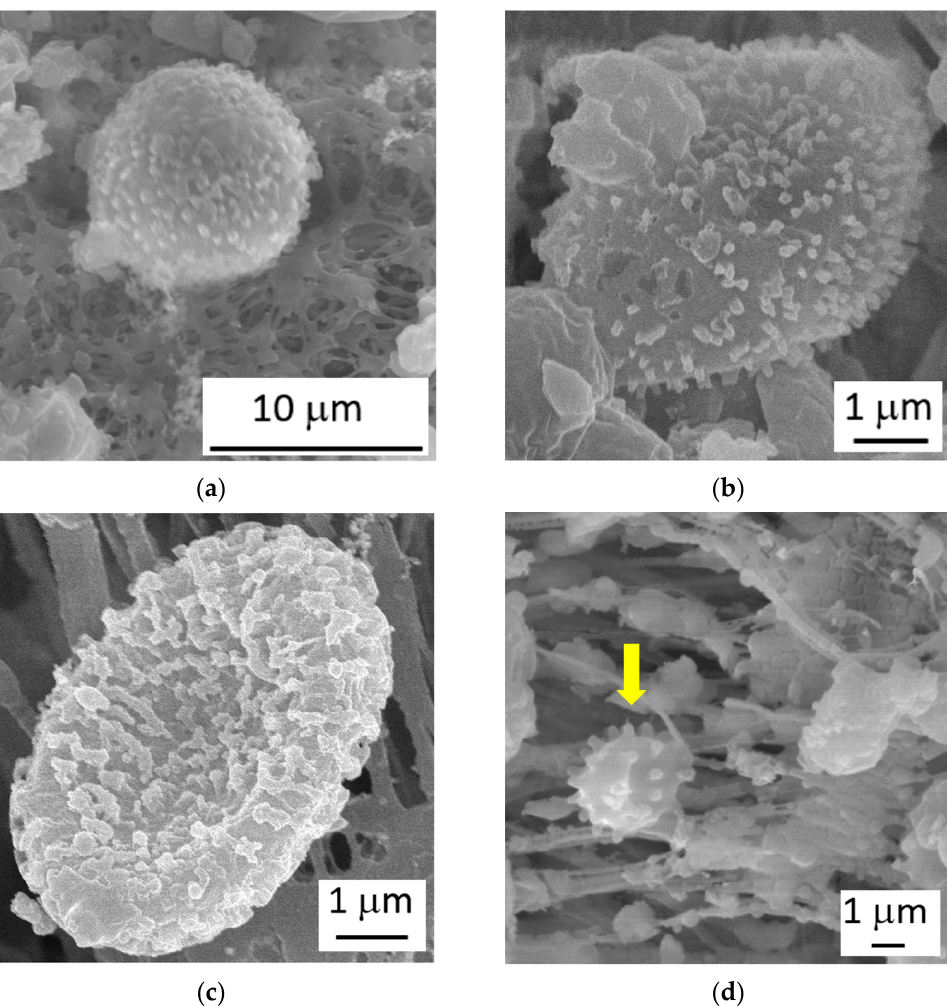
Figure 1. SEM images of various types of fungal spores found in aerosol samples in summer, Moscow, in different years: ( a )—2 July 2019; ( b )—28 June 2021; ( c )—14 July 2021; ( d )—14 July 2022, Yellow arrow indicates a fungal spore.